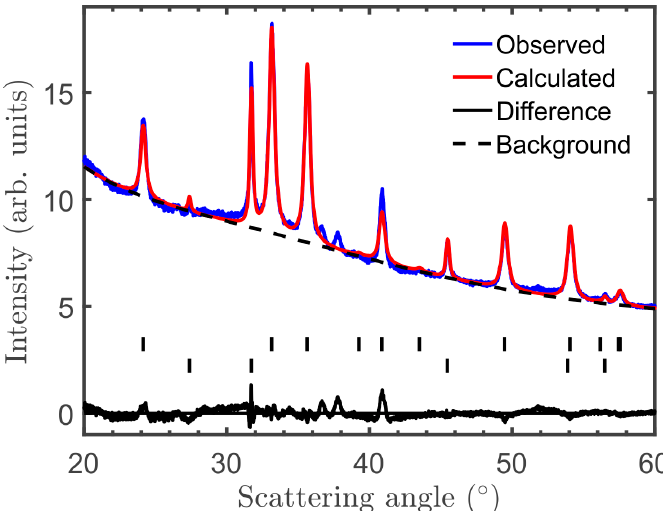
Figure 10. XRD patterns of the 2.5 mM NaCl sample after hydrothermal treatment at 140 °C. The upper tick marks correspond to the hematite structure, the lower to the NaCl